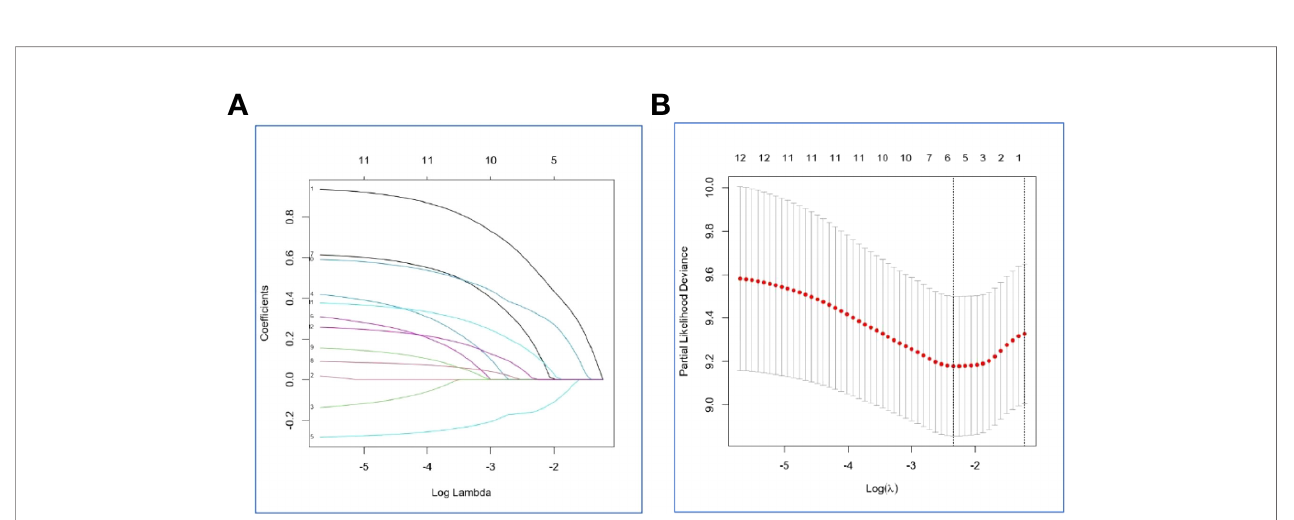
FIGURE 4 | Selection of the optimal prognostic factors for survival in the internal set by the LASSO model. (A) The LASSO-Cox regression model was used to select the prognostic factors. (B) Ten-fold cross-validation for tuning parameter selection in the LASSO model via minimum criteria and 1-SE